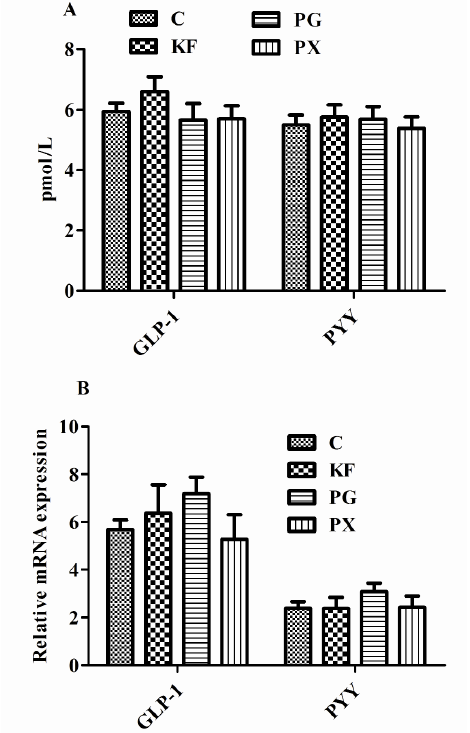
Figure 3. Plasma concentrations ( A ) and mRNA abundance in distal ileum ( B ) of GLP ‐ 1 and PYY in rats given diets containing different dietary fibers for three weeks; Diets were control (C) or supplemented with 2% fiber of konjac flour (KF), pregelatinized waxy maize starch plus guar gum (PG), or pregelatinized waxy maize starch plus xanthan gum (PX); Values are mean ± SEM, n = 6–8 per group. GLP ‐ 1, glucagon ‐ like peptide ‐ 1; PYY, peptide tyrosine ‐ tyrosine.